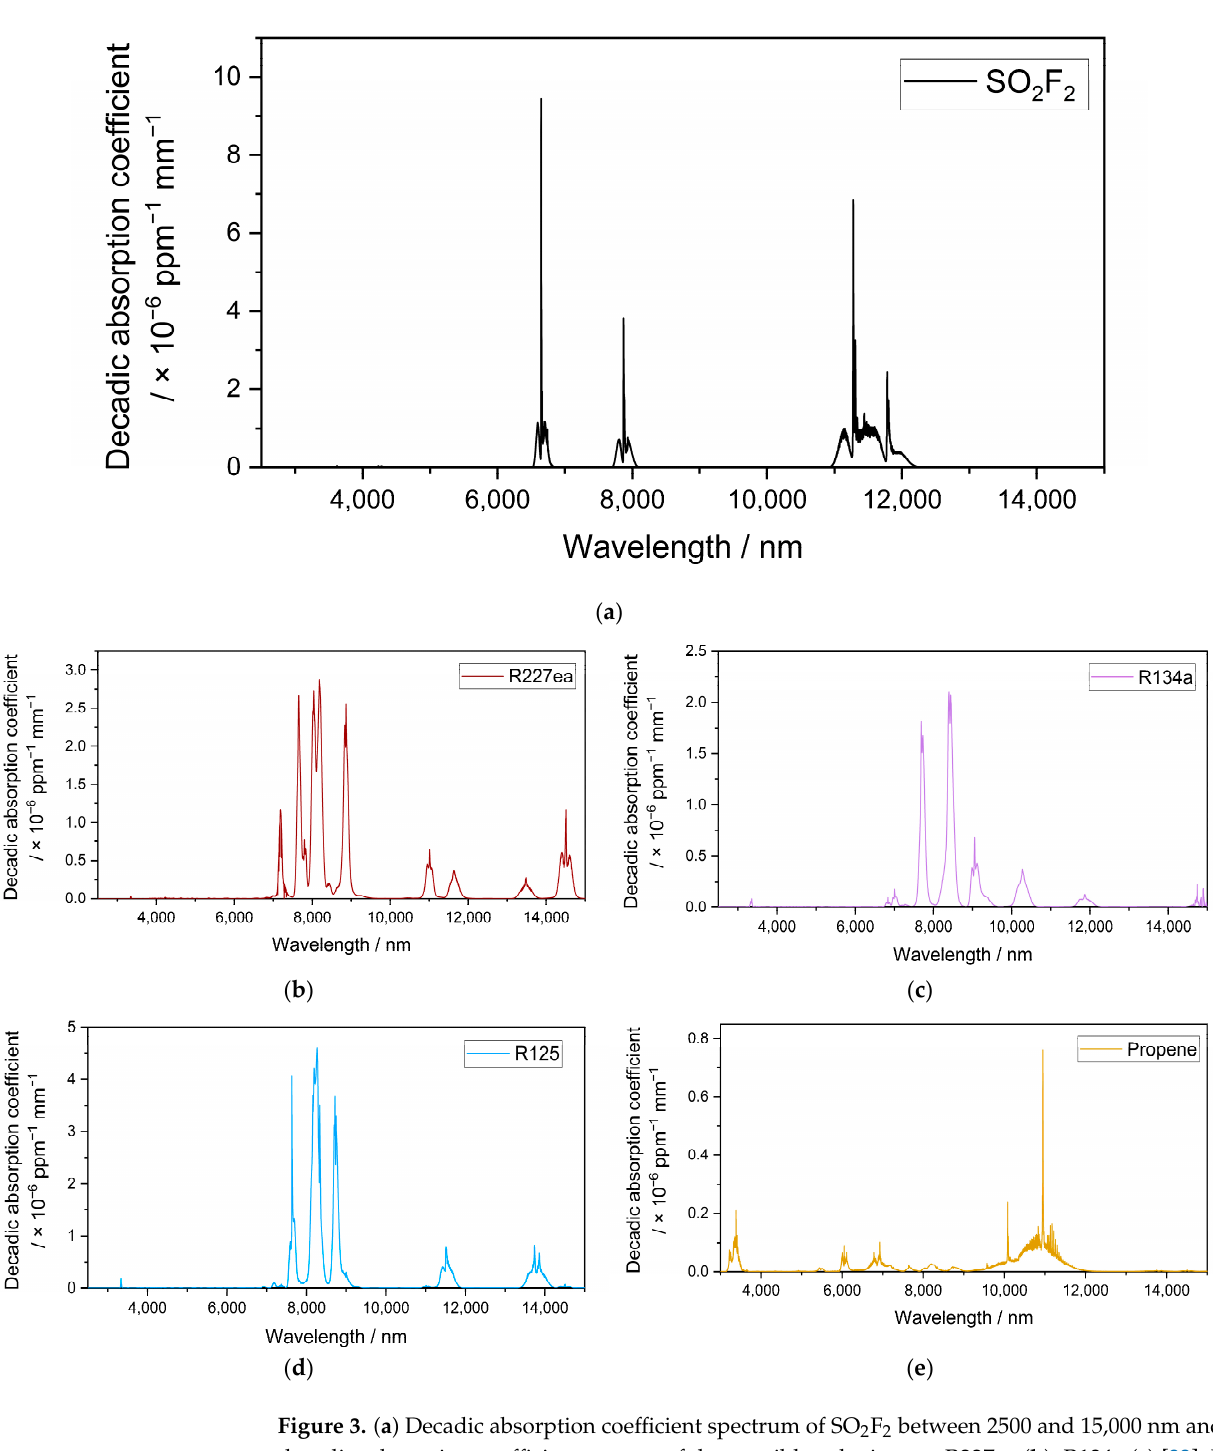
Figure 3. ( a ) Decadic absorption coefficient spectrum of SO 2 F 2 between 2,500 and 15,000 nm and the decadic adsorption coefficient spectra of the possible substituents R227ea ( b ); R134a ( c ) [32]; R125 ( d ) and propene ( e ) in standard